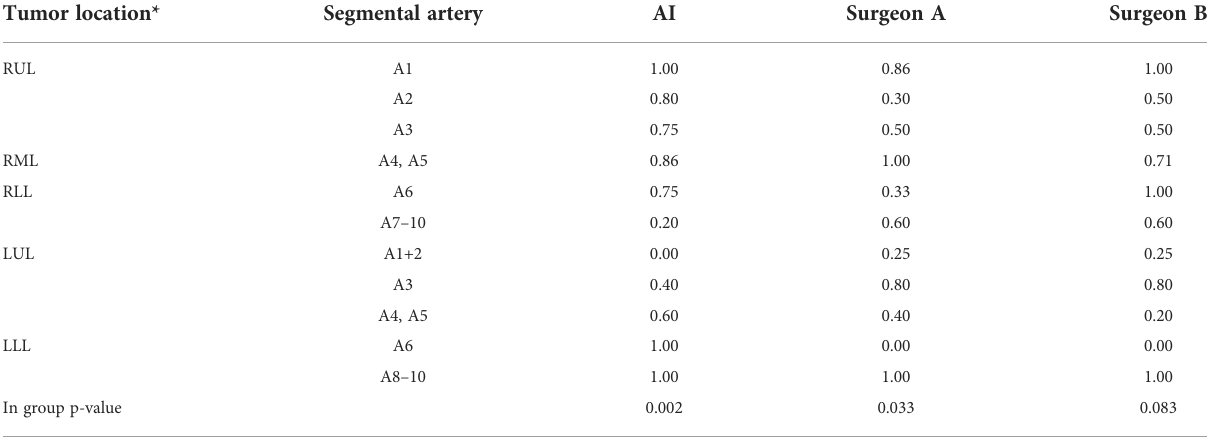
TABLE 2 Accuracy of the segmental artery in structure-wise error analysis. Tumor